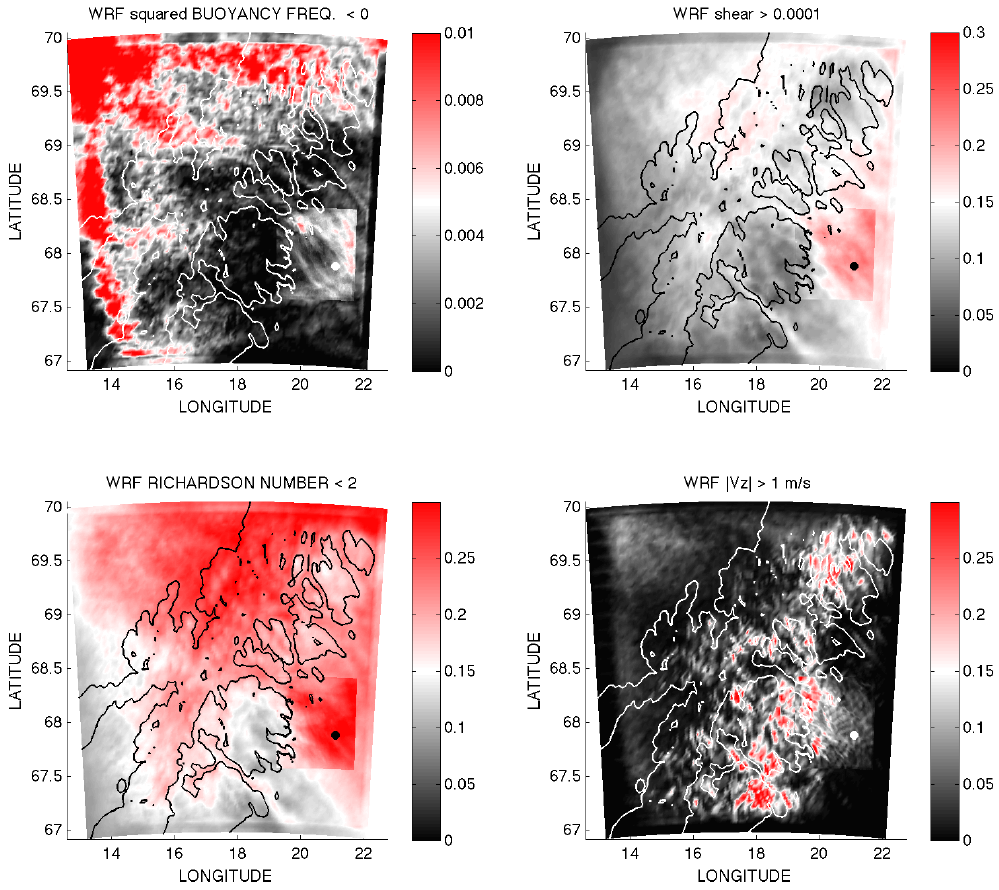
Fig. 14. Plan view of the occurrence rates of ω B < 0, vertical shear in horizontal wind > 0 . 001s − 1 , Richardson number < 2, and vertical wind > 1m/s. Occurrence rates give the average for the period 23–25 January 2003 and for the height interval 2000–5000m and are plotted first based on WRF simulations for an extended domain with 3km horizontal and 150m vertical resolution. Results for the 1km grid are then